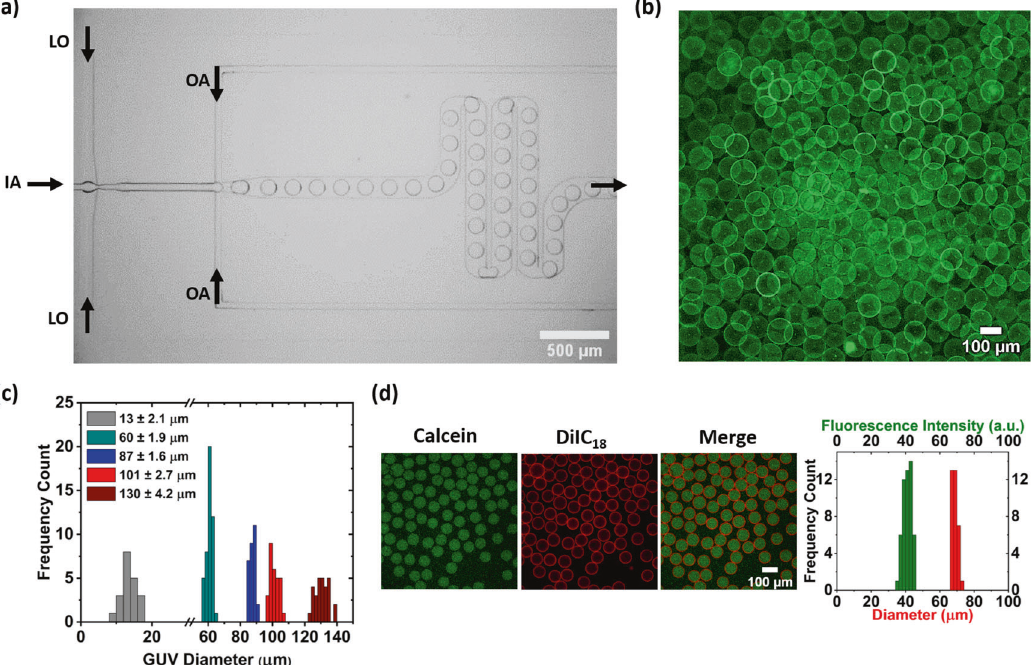
Fig. 2 Production of monodisperse additive-free pure-lipid liposomes. a The production process using the micro fl uidic double emulsion device with 50 mbar at the IA (inner aqueous solution), 57 mbar at the OA (outer aqueous solution) and 44 mbar at the LO (lipid oil). b Confocal fl uorescence image of GUVs with lipid composition POPC (99.5 mol%) and DiD (0.5 mol%) obtained with only water as the IA and OA. c Size distributions of the liposomes for different fl ow rate con fi gurations, showing high size monodispersity over a wide range. d Confocal fl uorescence images of negatively charged GUVs with lipid composition POPC (79.5 mol%), DOPS (20 mol%), DiIC 18 (0.5 mol%) containing calcein (10 µ M) together with the encapsulation ef fi ciency (100%) and uniformity (RSD 6.2%) as well as their size homogeneity (67 ± 2 µ m, RSD